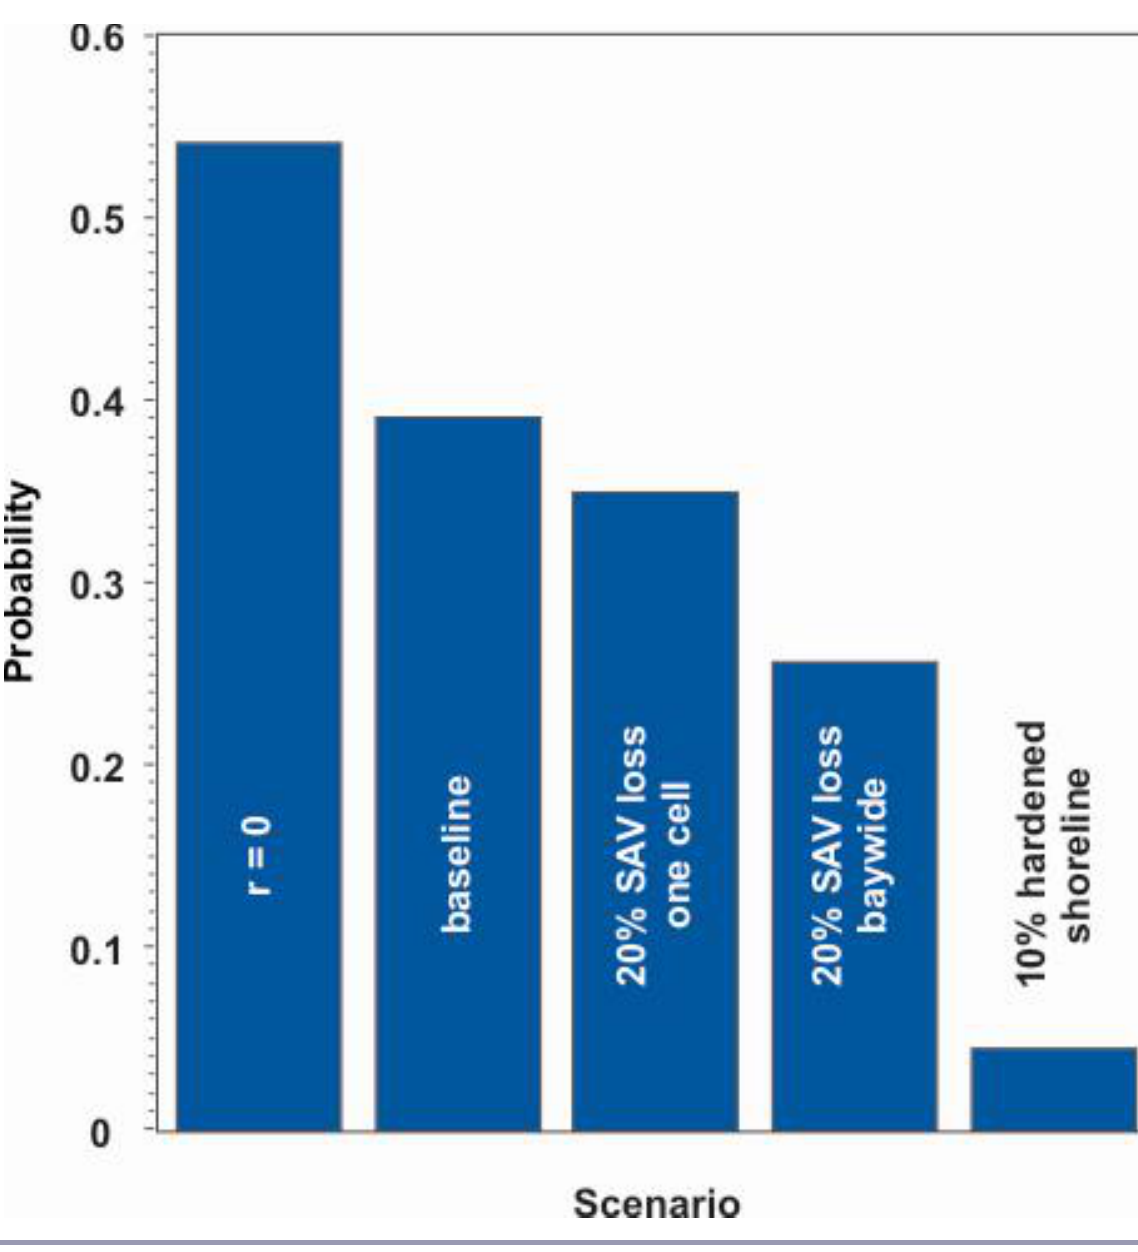
Fig. 9. Probabilities of attaining 2004 levels of blue crab harvest in 2046–2050 based on five modeled scenarios of habitat loss. SAV = shoreline aquatic